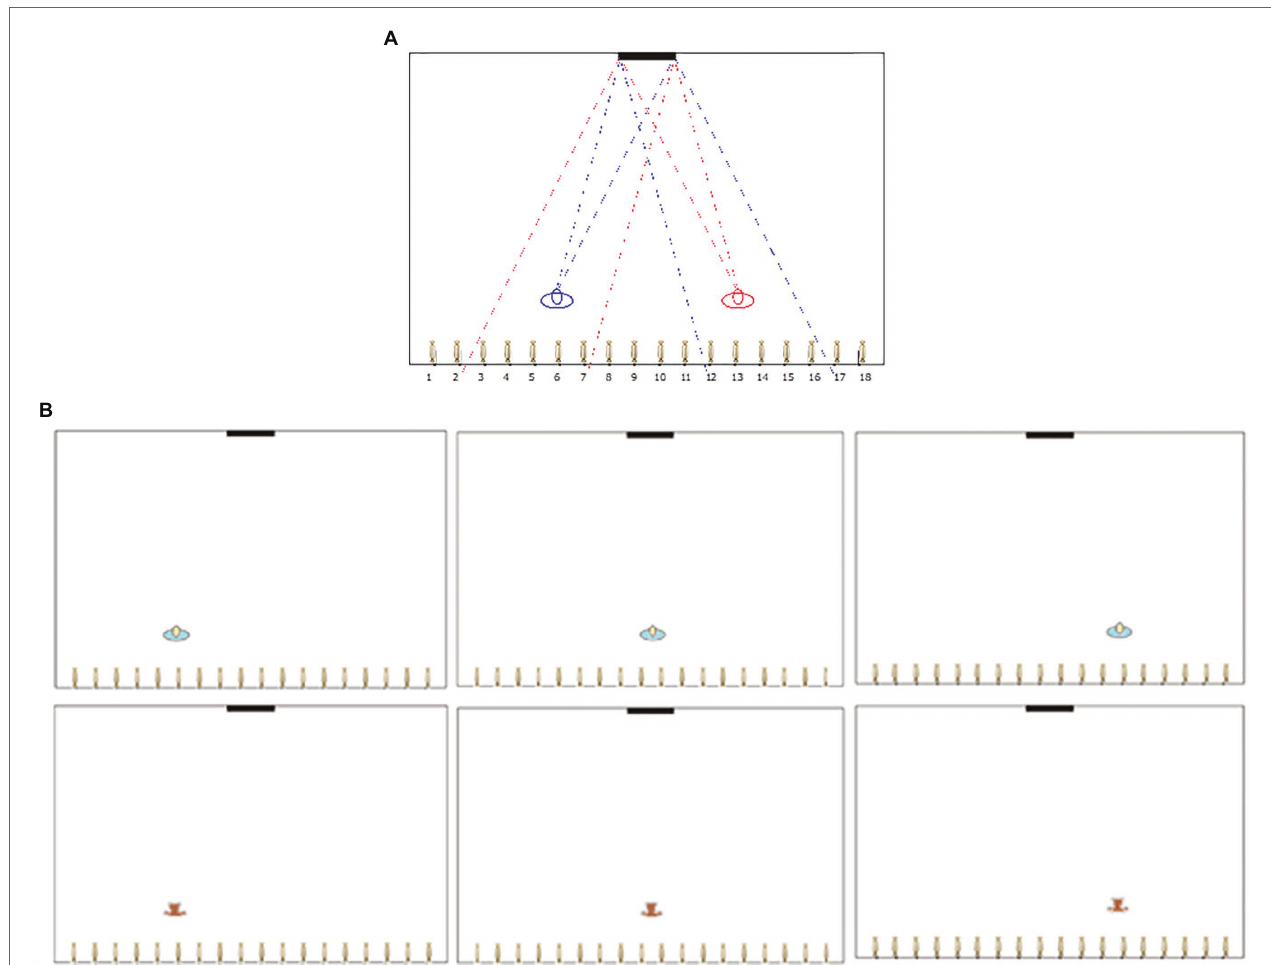
FIGURE 1 | (A) The Room Observer and Mirror Perspective test (ROMP) task is based on the diagram of a room containing an observer and a mirror. The task is to select what objects on the back wall would be visible to the observer. For illustration, we overlap two observers. For the observer on the right, the visible sweets are 3–7; for the observer on the left, the visible sweets were 12–16. (B) Six layouts used in this study. Each diagram was printed on A4 paper. The columns show the three locations (left, middle and right), and the rows show the two observers (Child, Teddy